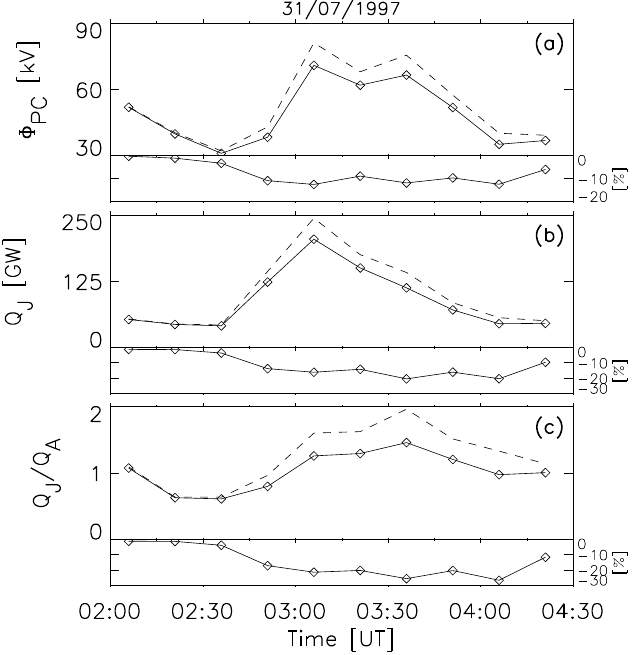
Fig. 11. (a) Polar cap potential drop 8 PC , (b) Joule heating rate Q J and (c) the ratio Q J /Q A between Joule heat- ing and energy flux estimated through- out the time interval between 02:00 and 04:20 UT on 31 July 1997. The parameters have been calculated with- out (dashed line) and with (solid line) PIXIE data. The differences in per- cent when including PIXIE measure- ments are also